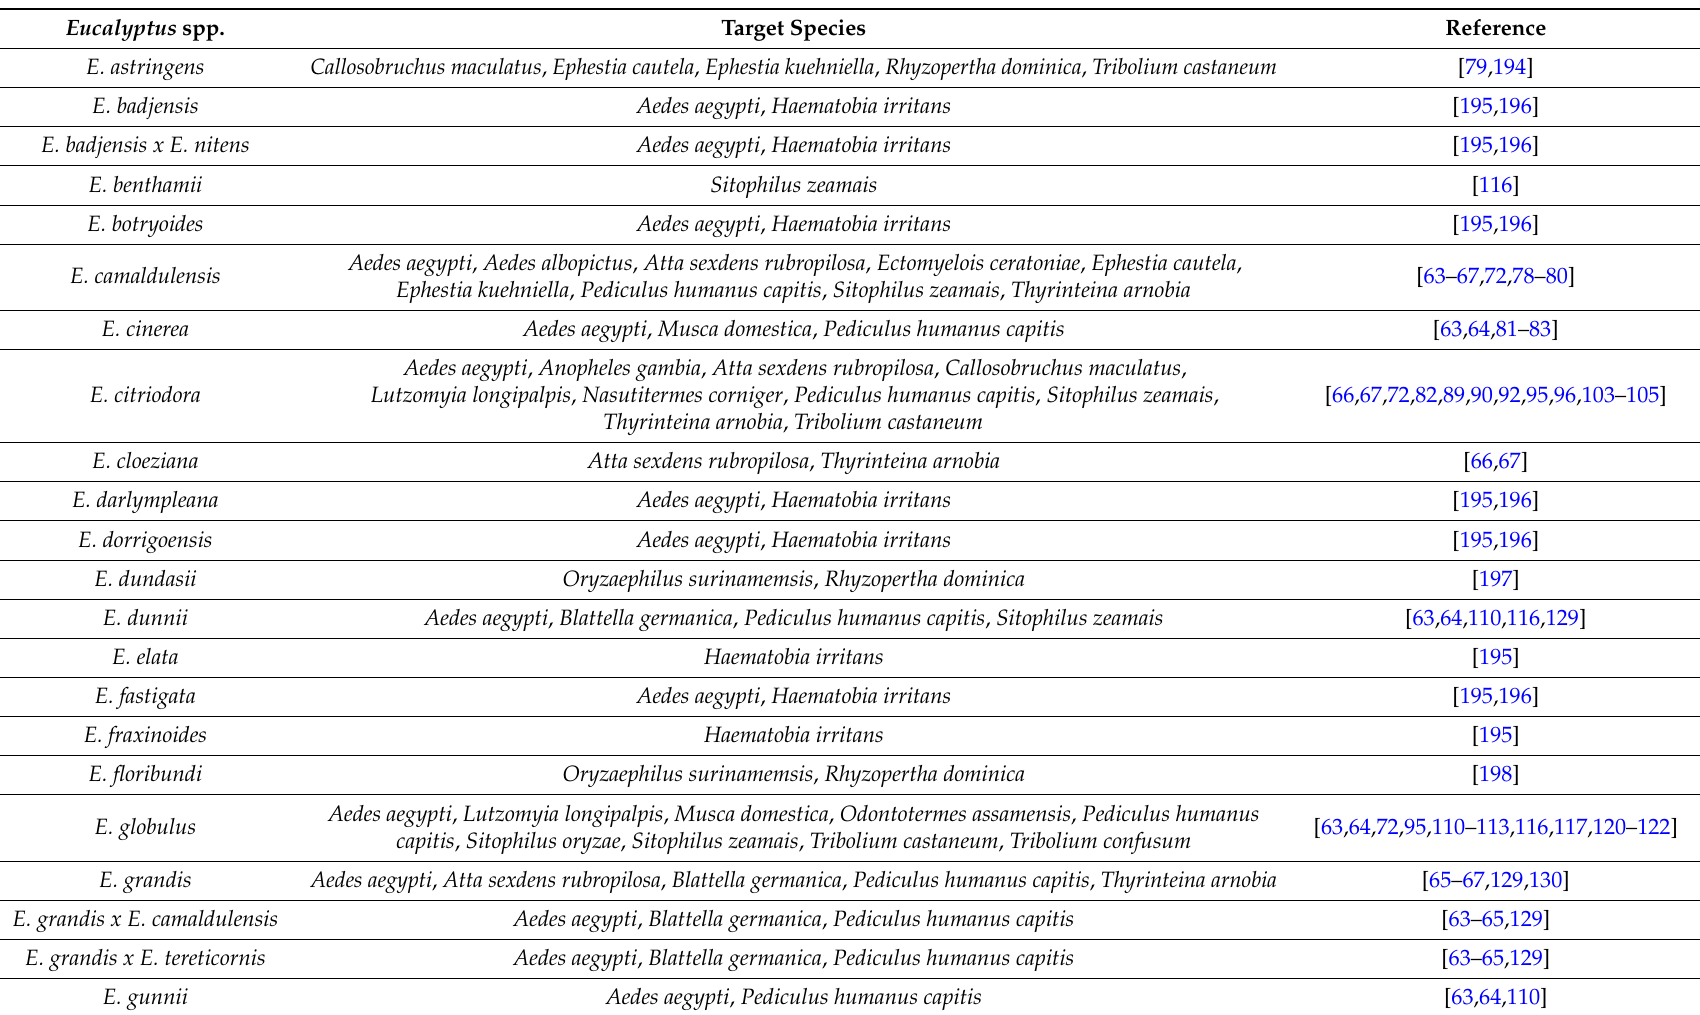
Table 5. Eucalyptus spp. essential oils with insecticidal activities.